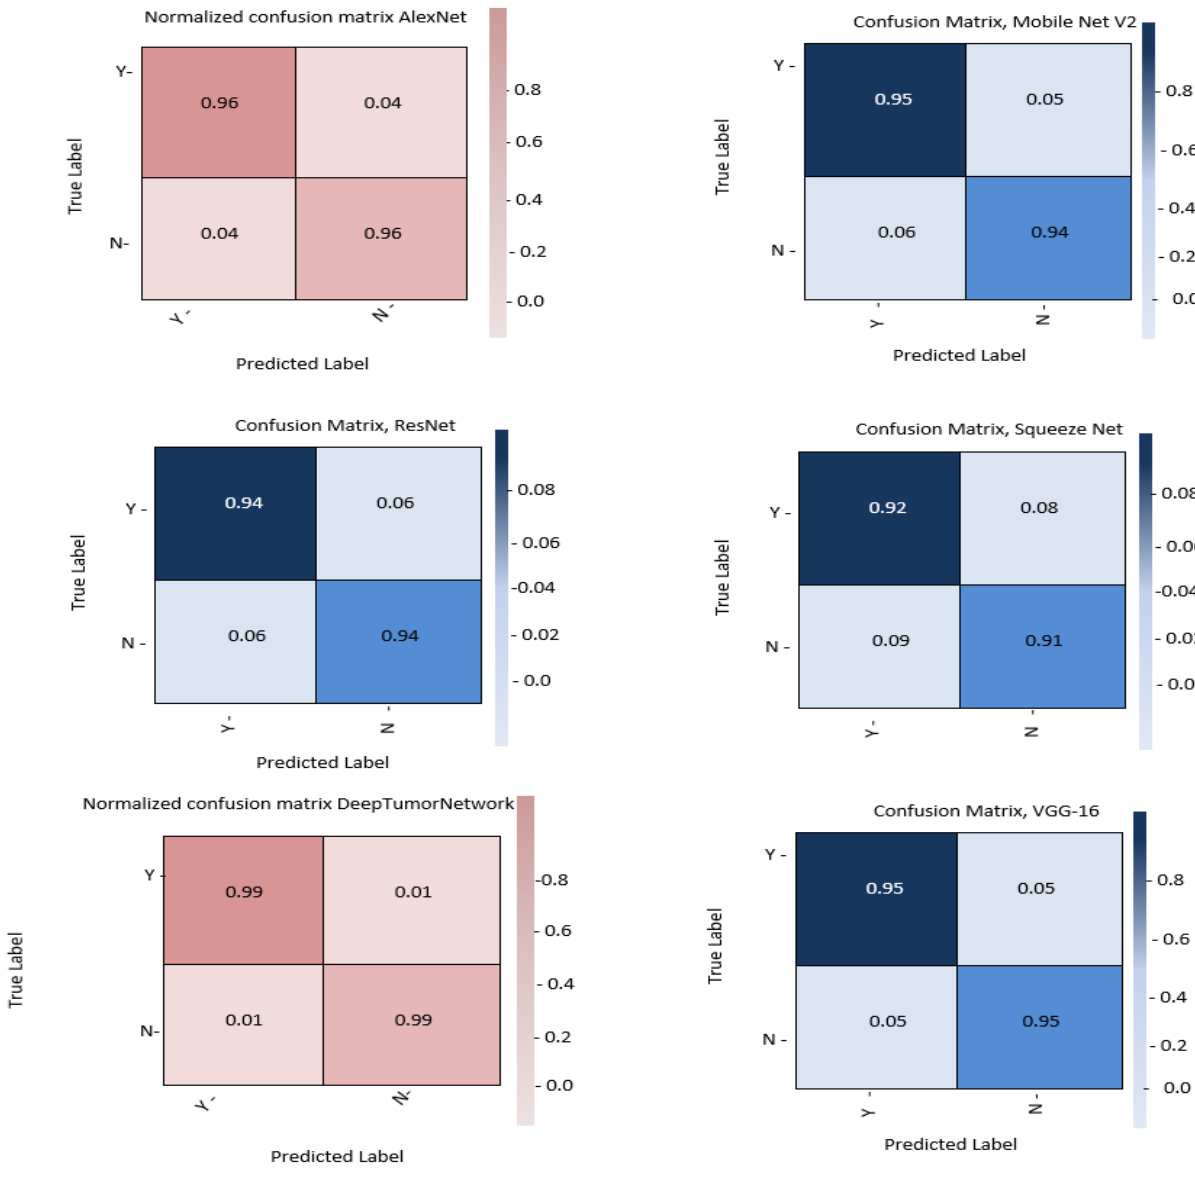
Figure 10. The confusion matrix of the proposed model with other TL model of BTs classification.